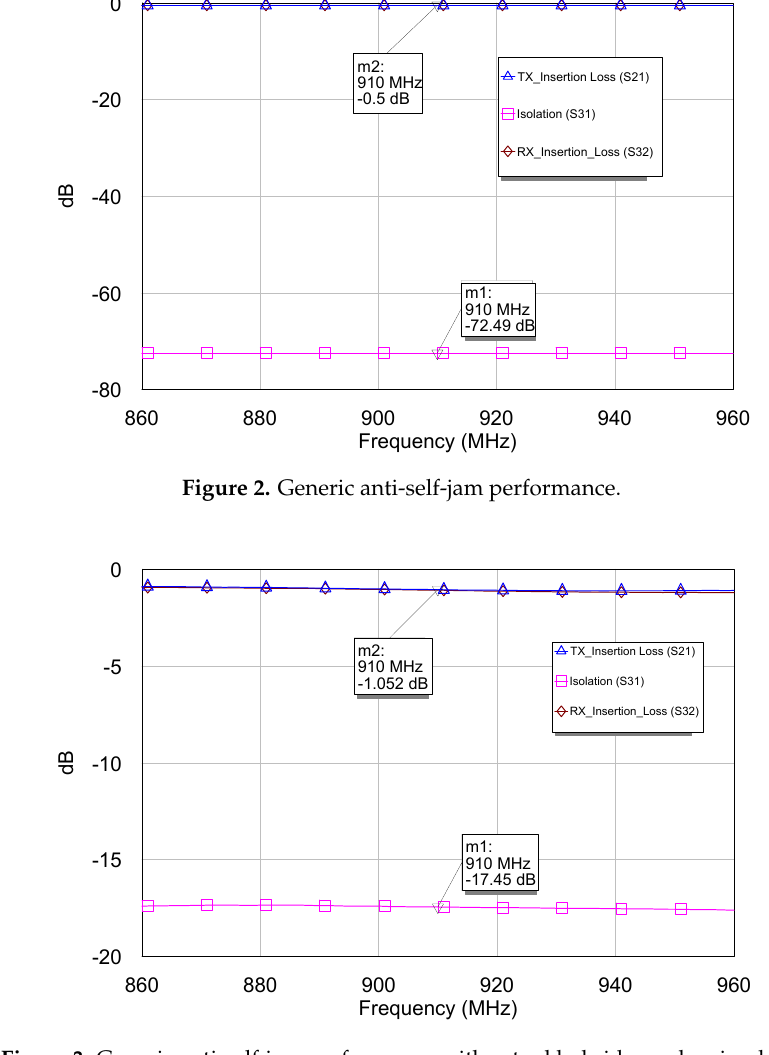
Figure 3. Generic anti-self-jam performance with actual hybrid couplers in